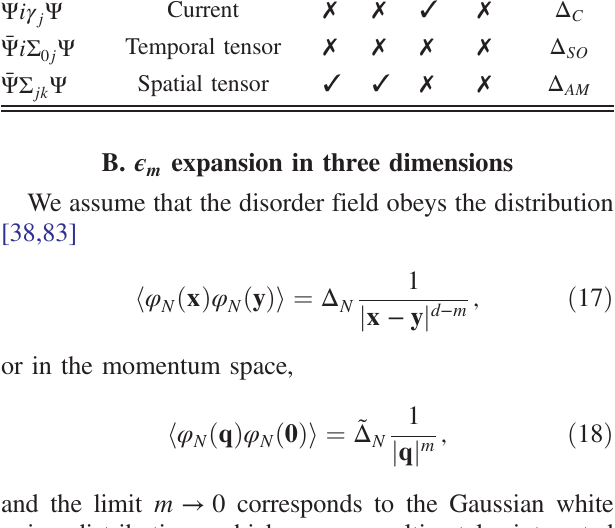
dimensions of the momentum and frequency are ½ q (cid:3) ¼ 1 and ½ ω (cid:3) ¼ z . The form of the Euclidean action [see